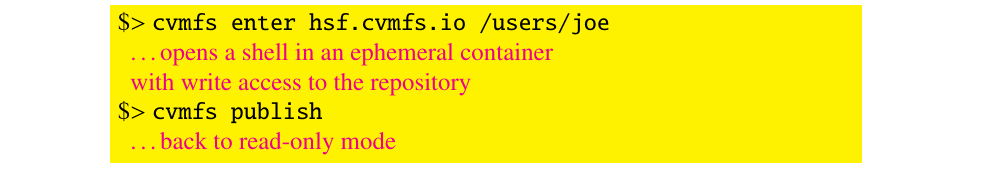
Figure 4. The cvmfs enter command creates an isolated environment through namespaces as de- scribed in Section 4. The writable mountpoint inside this mini container is provided by the CernVM-FS client and the Fuse implementation of the OverlayFS union file